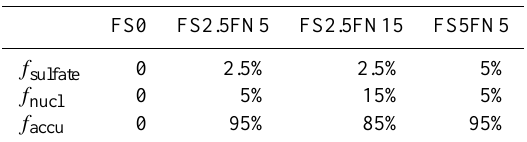
Fig. 2. Same as Fig. 1, except for the nucleation rate ( J ). Table 1. Overview of the four simulations presented in this